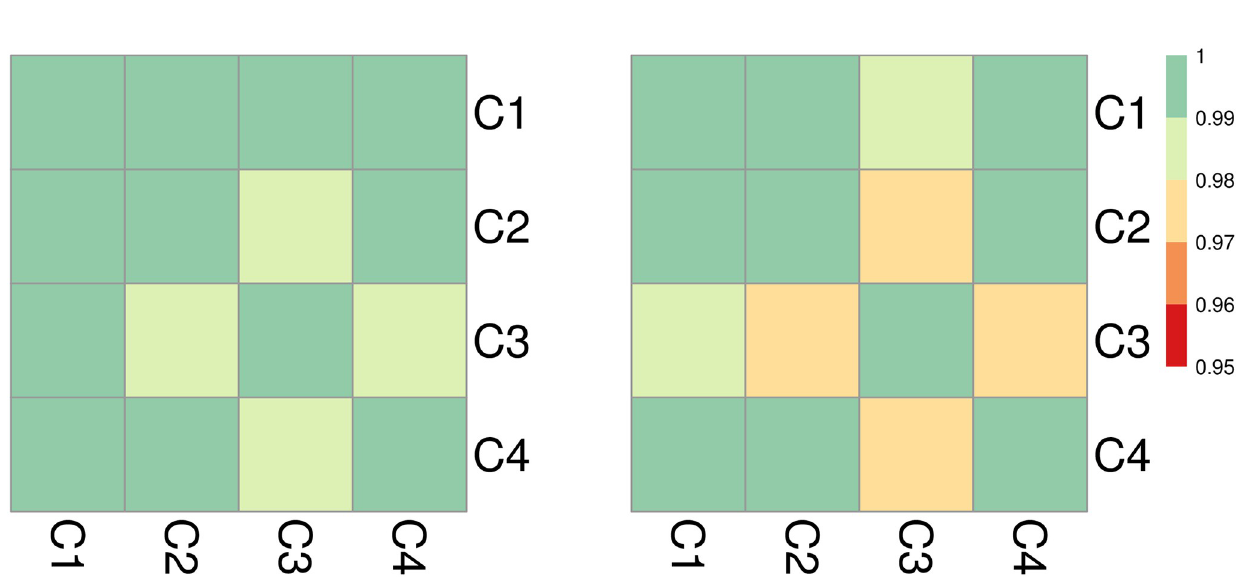
Fig 9. Cluster dynamics in Israel: (left) Pearson’s correlation of weekly events n across pairs of clusters. (right) Pearson’s correlation of differentiated j weekly events Δ n = n across pairs of clusters. The left panel shows almost perfect correlation between weekly-based streams of events for all cluster j j − n j − 1 pairs. The synchrony remains almost perfect when considering first-order differences in the right. The nationwide correlation that is much more visible than in India or Mexico may be due to Israel’s more compact geographical extension, linguistic unity, tighter virtual connectivity, and/or due to the nationwide engagement of the Flag movement. Note that correlation coefficients between clusters in Israel are very large (r � 0.95 in all cases) compared to those computed for India (and Mexico). Thus, if we kept the same scale as in Figs 6 and 12 (-1 � r � 1) the correlation plots for Israel would be colored uniformly. Instead, for a more nuanced view we use instead a more restricted scale (0.95 � r � 1).